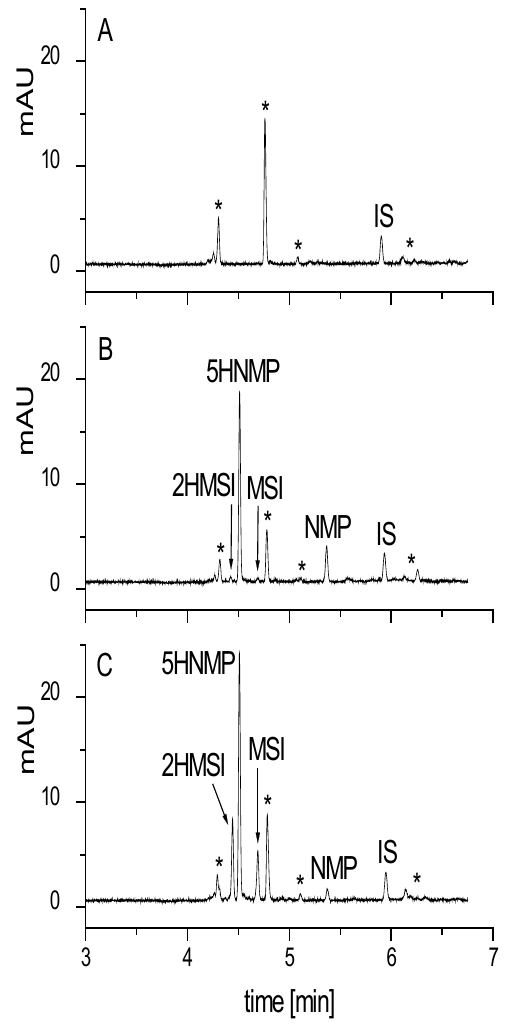
Figure 5. Electropherograms of (A) sample No 1, control rat urine, (B) sample No 2 and (C) sample No 3. B and C represent the 0-6 h and 6-24 h post-exposure voided urine of two rats dosed with NMP (308 mg kg -1 body wt., ig.). IS is 5-methyl-2-pyrrolidone. The most intensive unknown compounds are marked with an asterisk. The experimental conditions are the same as in Fig.